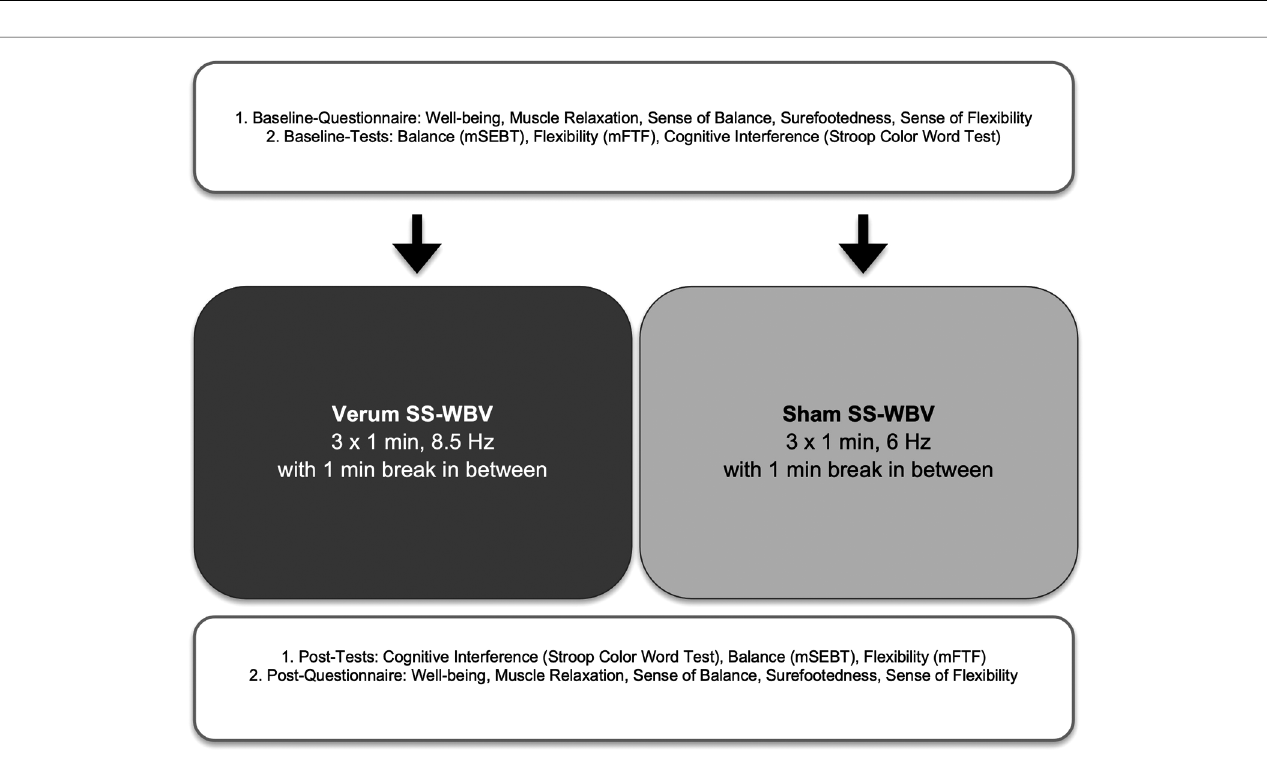
FIGURE 3 Flowchart of the procedure. Baseline-measurements started with the baseline questionnaire and were followed by the Stroop Color Word Test, fl exibility test (mFTF) and then balance test (mSEBT); The sinusoidal side-alternating vibration exercise with the MediPlate® consisted of three series that lasted one-minute each with two one-minute breaks in between; Focusing on immediate effects on cognitive interference, participants attended the post-tests (starting with the Stroop Color Word Test, followed by the mSEBT and then mFTF) before the